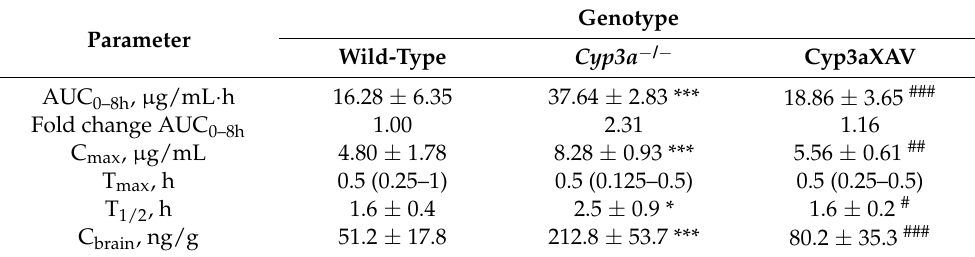
Figure 5. Plasma concentration-time curves ( A ), semi-log plot of plasma concentration-time curves ( B ), and plasma AUC 0–8h ( C ) of repotrectinib in female wild-type, Cyp3a − / − , and Cyp3aXAV mice 8 h after oral administration of 10 mg/kg repo- trectinib. Data are presented as mean ± S.D. (n = 6). *, P < 0.05; **, P < 0.01; ***, P < 0.001 compared to wild-type mice. # , P < 0.05; ## , P < 0.01; ### , P < 0.001 comparing Cyp3aXAV mice to Cyp3a − / − mice. Table 3. Plasma, brain, liver, and small intestine pharmacokinetic parameters of repotrectinib in female wild-type, Cyp3a − / − and Cyp3aXAV mice over 8 h after oral administration of 10 mg/kg